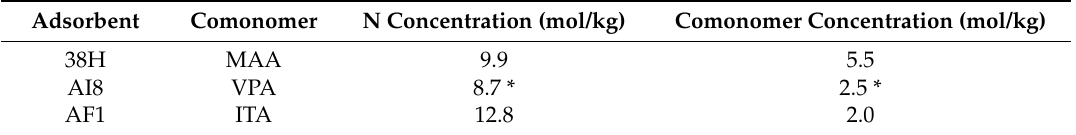
Table 2. Summary of nitrogen and comonomer surface concentrations after preparation of sorbent materials. Adsorbent Comonomer N Concentration (mol/kg) Comonomer Concentration